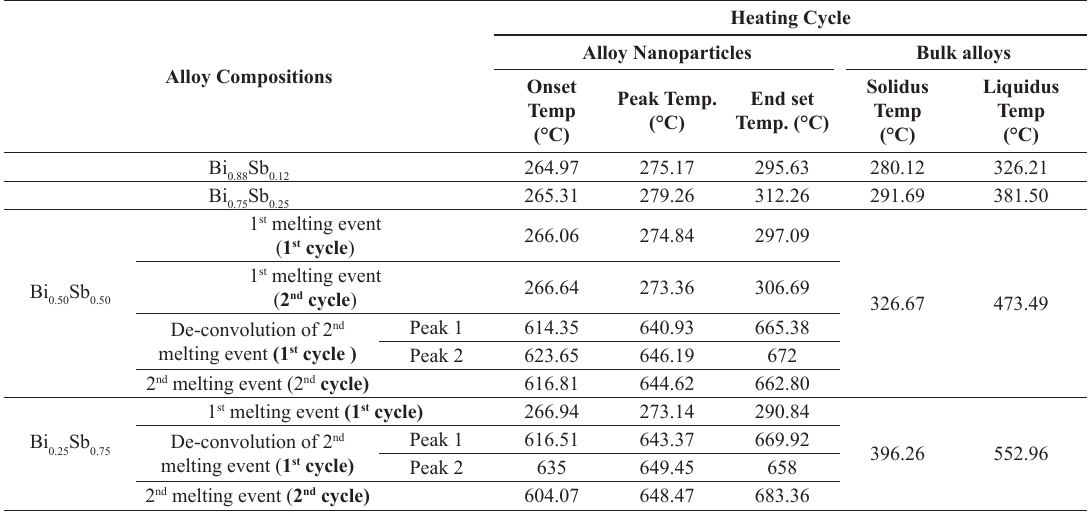
Table 1. Comparison of DSC Data for different alloy compositions of Bi route at 140 °C for 12h using MR of precursor/NaBH equilibrium phase diagram.